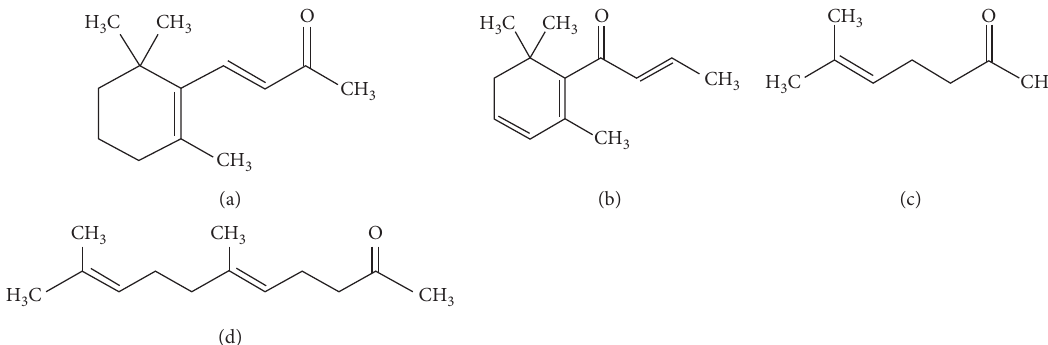
Figure 1: Molecular structure of several apocarotenoid aromas in tomato fruit: (a) β -ionone; (b) β -damascenone; (c) 6-methyl-5-hepten-2- one; (d) geranyl